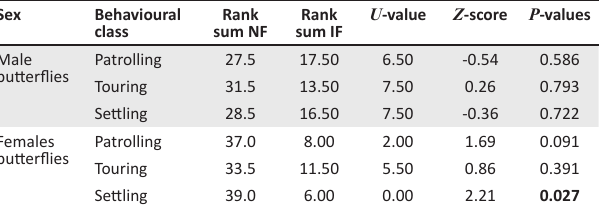
TABLE 3: Results of Mann–Whitney U tests of sex-specific behavioural incidences within each studied behavioural classification in natural and invaded forest patches in a dairy farming